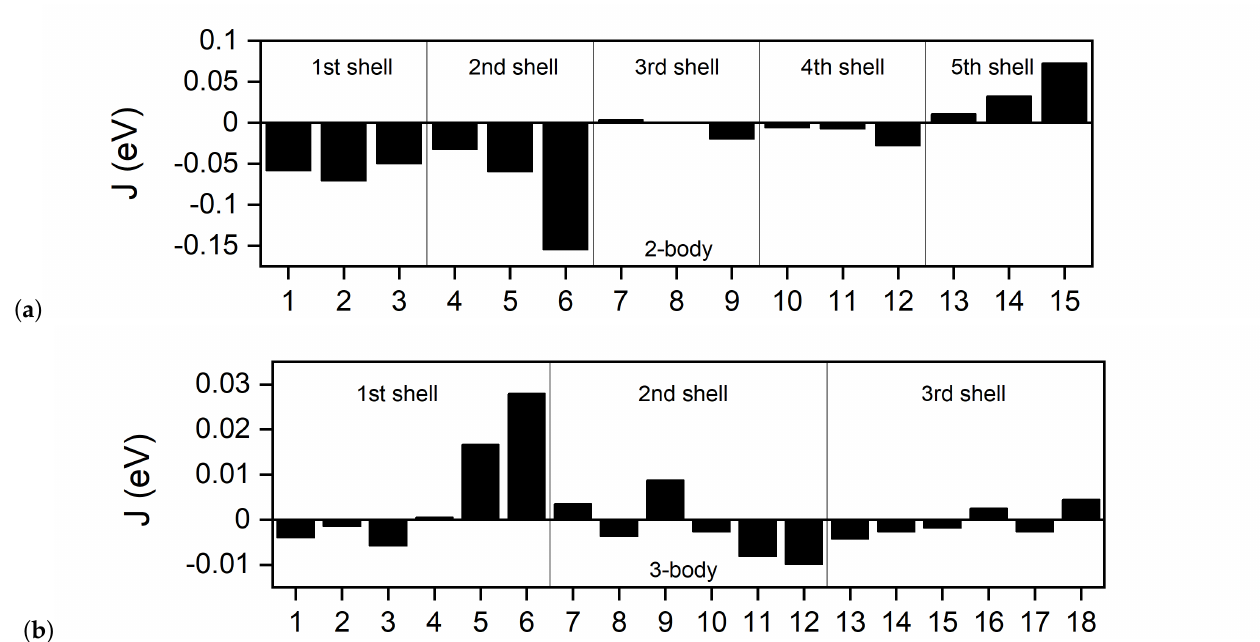
Figure 3. Effective cluster interactions obtained from Cluster Expansion Hamiltonian for ( a ) pairs with up to fifth nearest neighbour and ( b ) three smallest 3-body clusters. Table 1. Effective cluster interactions obtained for the Cr-W-Y system. Cluster size is denoted by | ω | , shell label is denoted by n , ( s ) are the decorations of the clusters, m ( s ) J are the concentration-independent effective cluster interactions in | ω | , n